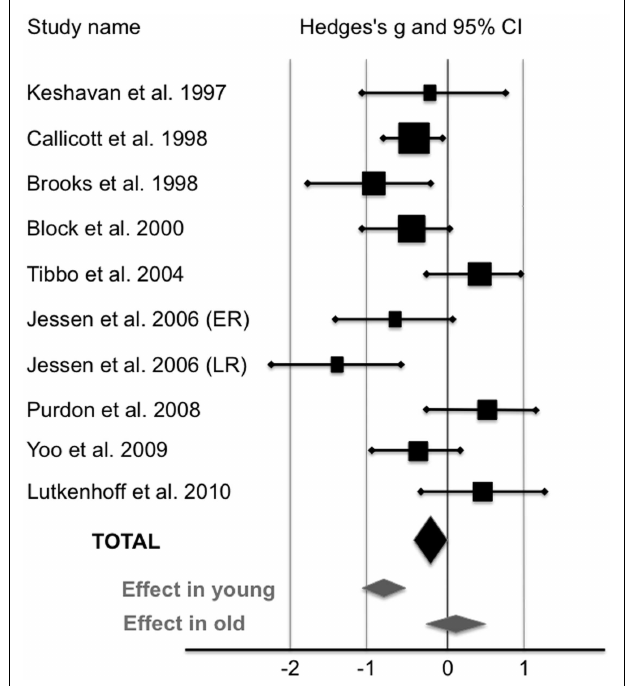
FIGURE 1 | Levels of NAA/Cr in the prefrontal cortex of high-risk subjects compared with healthy controls (random-effects model) .The horizontal line represents the confidence interval for each study, and each square represents the point estimate.The size of the square corresponds to the weight of the study.The diamond represents the pooled effect size estimate in the whole HRS sample (black diamond), in young HRS (i.e., who have not reached the peak age of risk for schizophrenia; < 40), and in old HRS (i.e., who have already passed the peak age of risk for schizophrenia; > 40) (gray